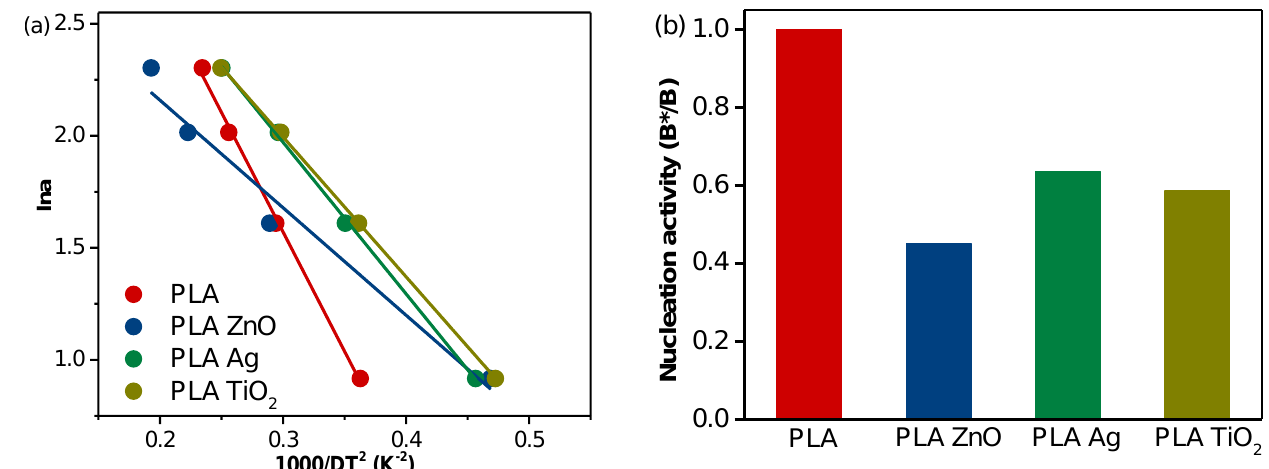
Figure 5. ( a ) Dobreva plots and ( b ) nucleation activity of PLA and its nanocomposites during their non-isothermal cold crystallization after fitting the data of the heating rates 2.5, 5, 7.5, and 10 °C/min.